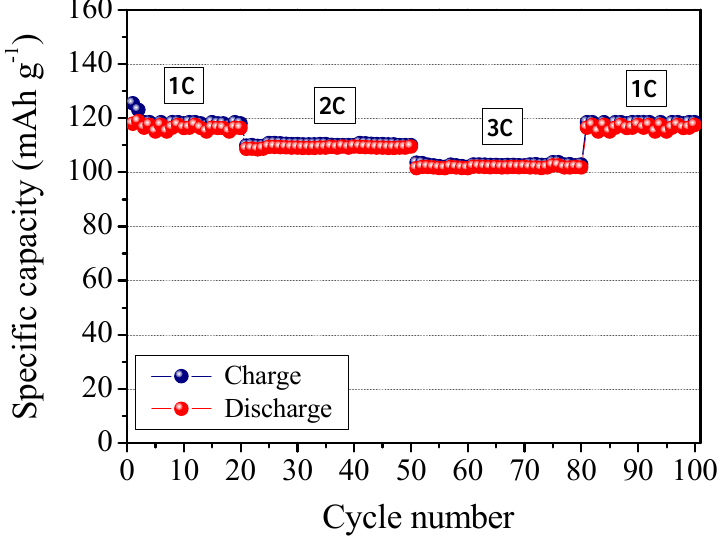
Figure 11. Ambient temperature cycling performance of a LiFePO cell, at different C-rates, from 1C to